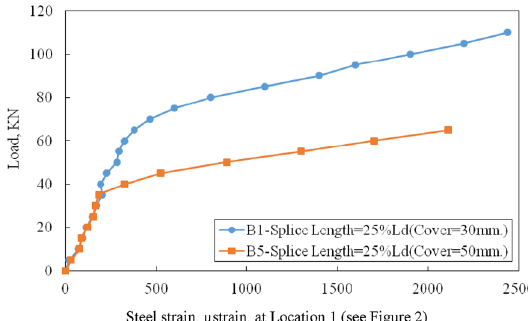
Fig. 12 Load–longitudinal steel strain of Beams B1and